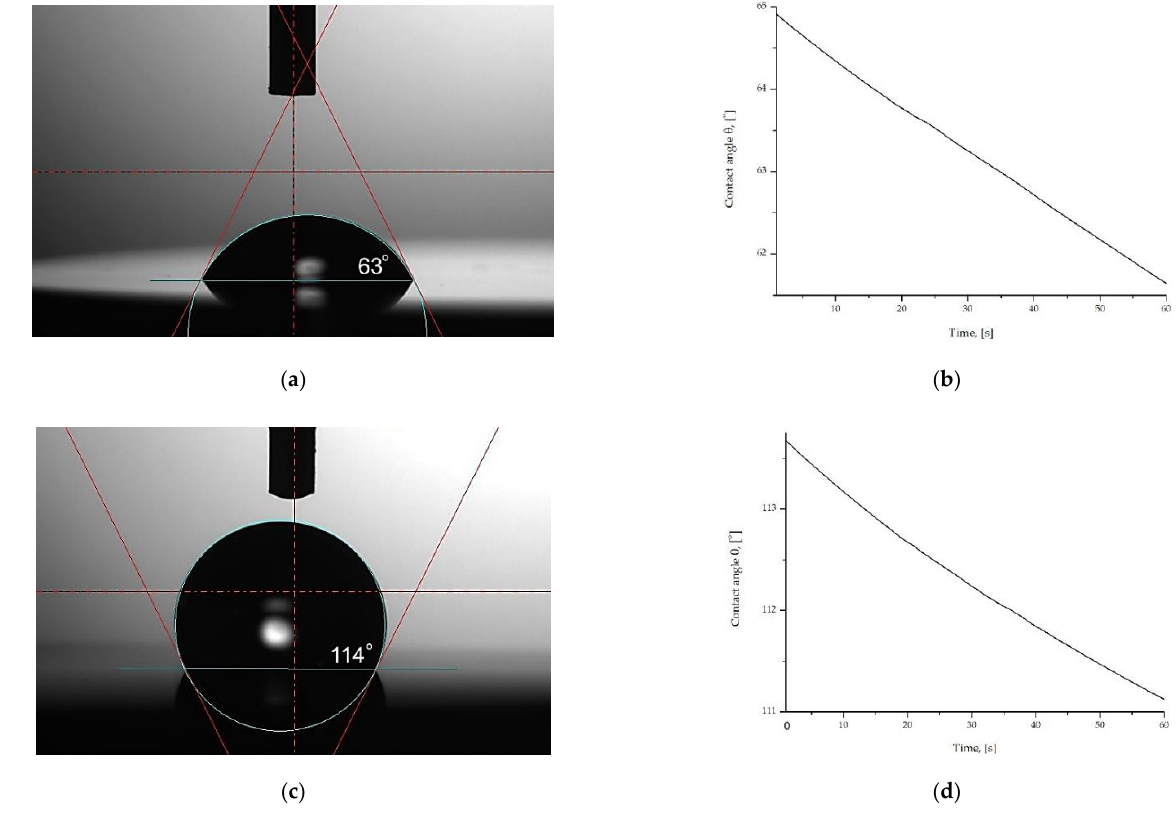
Figure 11. Results of contact angle measurements ( a ) drop M1; ( b ) contact angle values changes in time function M1; ( c ) drop M2; ( d ) contact angle values changes in time function M2.